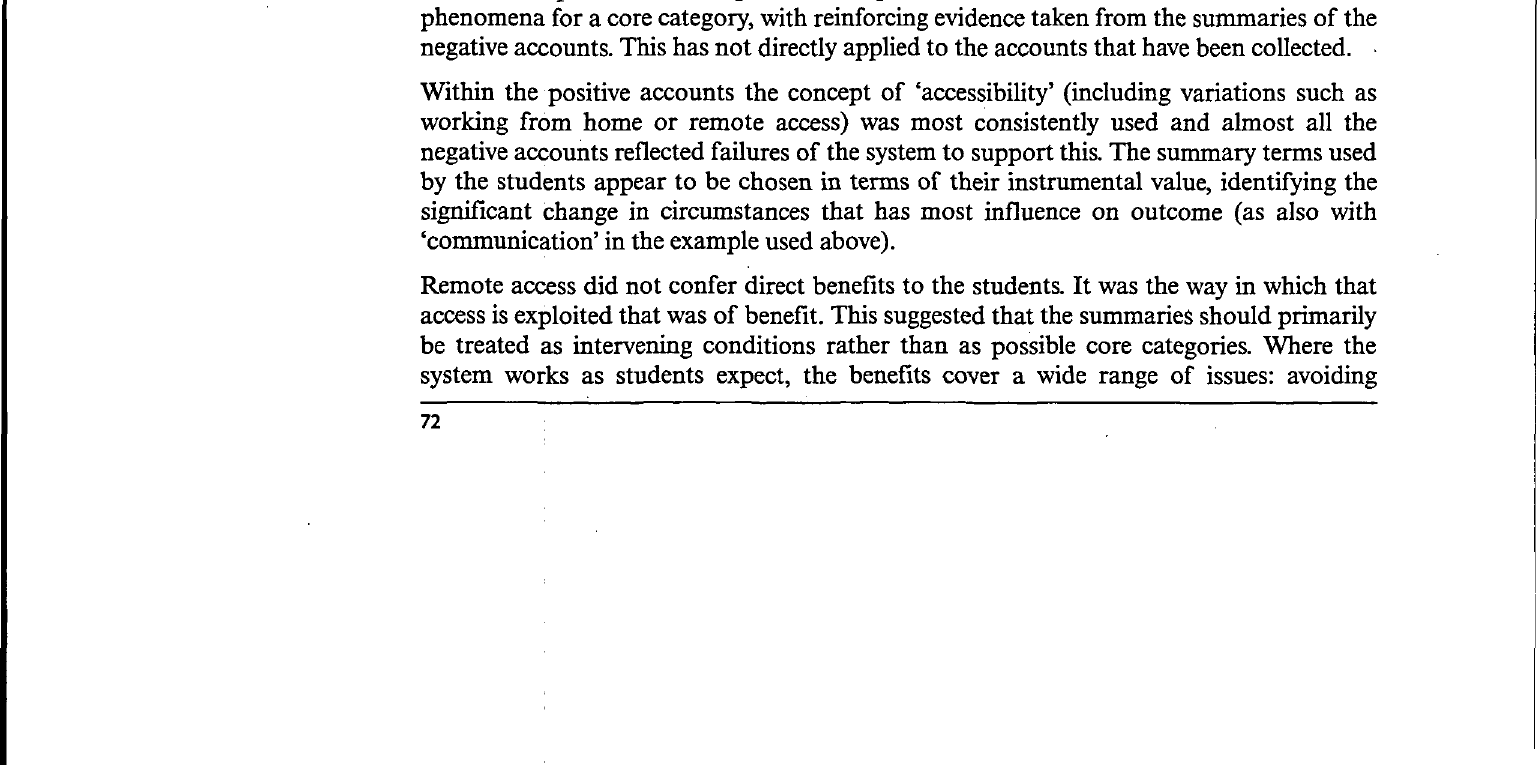
Figure 5: A formulation of the account incorporating an assessment of